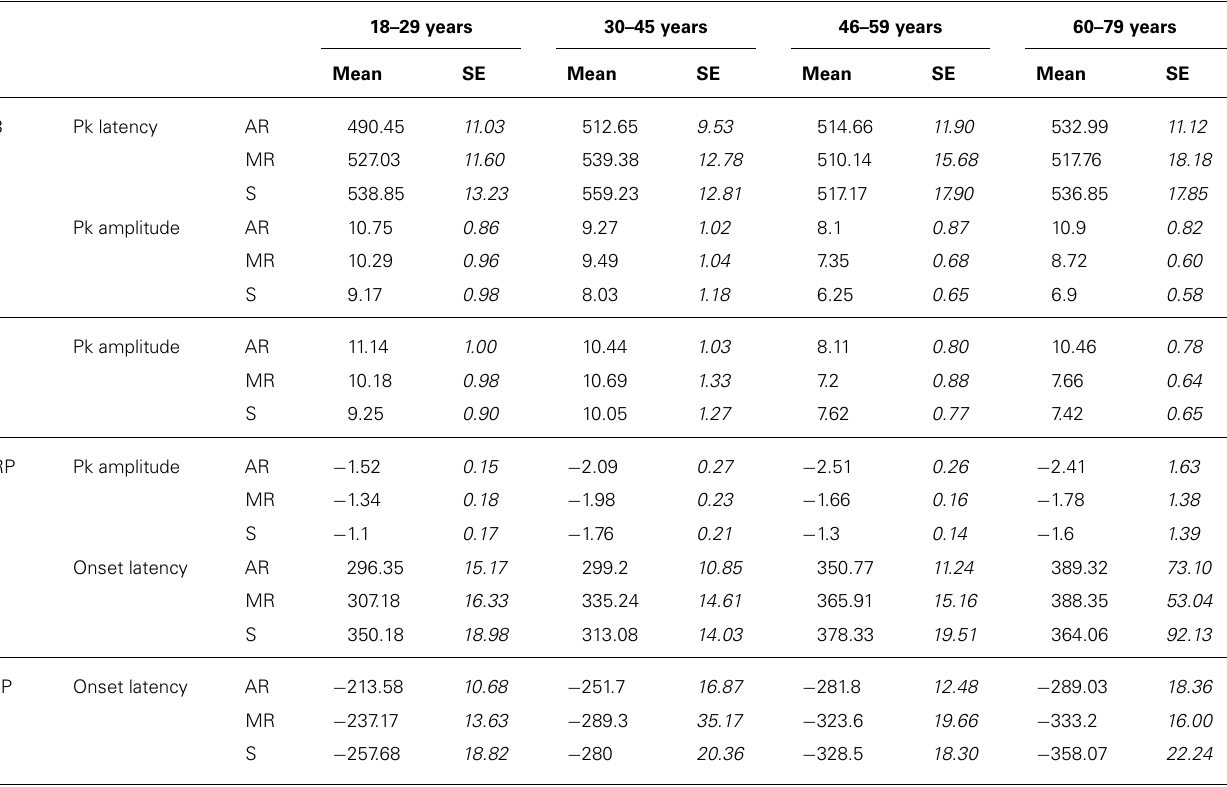
Table 2 | ERP measures for stimulus-locked (sP3), response-locked P3 (rP3), stimulus-locked LRP (sLRP), and response-locked LRP (rLRP) for each age group.